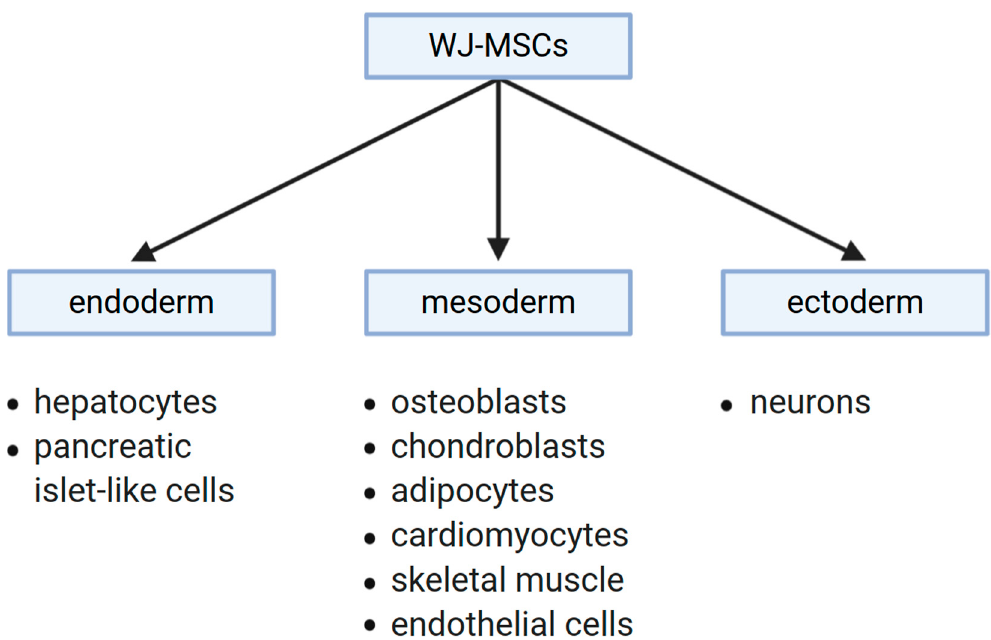
Figure 3. Stromal cells from Wharton’s jelly have a broad differentiation capacity and are able to to transform into cells of all three primary germ layers: endoderm, ectoderm, and transform into cells of all three primary germ layers: endoderm, ectoderm, and mesoderm. The endodermal lineages obtained from WJ-MSCs include hepatocytes or pancreatic islet-like cells. Differentiation of WJ-MSCs towards mesodermal lineages resulted in obtaining cells such as osteoblasts, chondroblasts, adipocytes, cardiomyocytes, skeletal muscle cells, or endothelial cells. Transformation of WJ-MSCs into neurons, which are of ectodermal origin, has also been achieved.